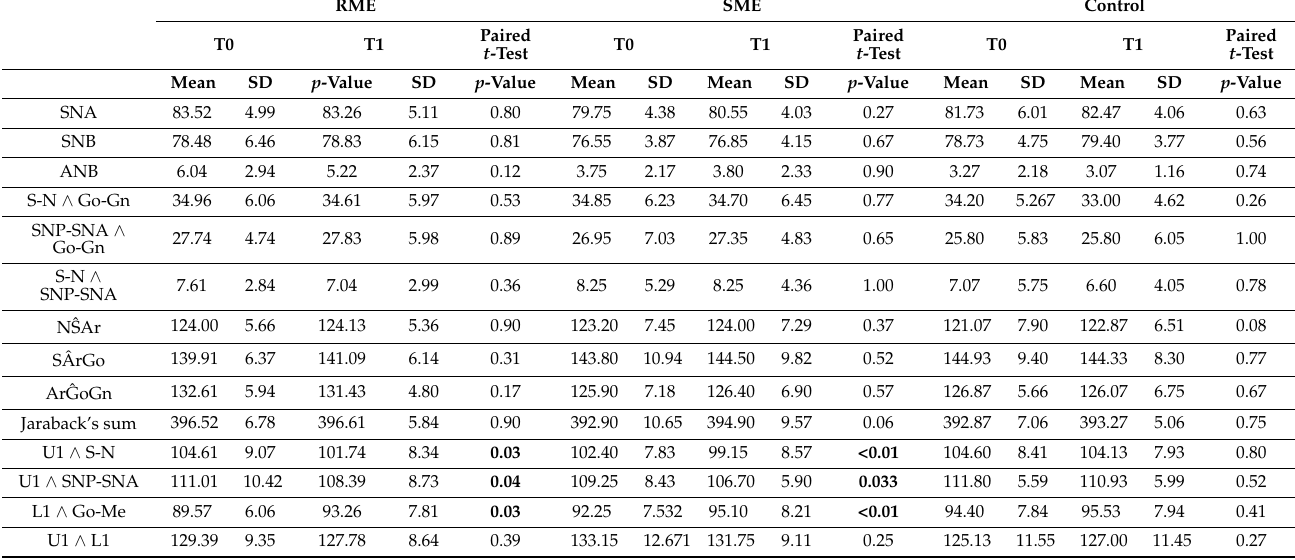
Table 3. Cephalometric measurements of the three groups reported at T0 and T1 and paired t -test analyses of the changes that occurred between the two time points.